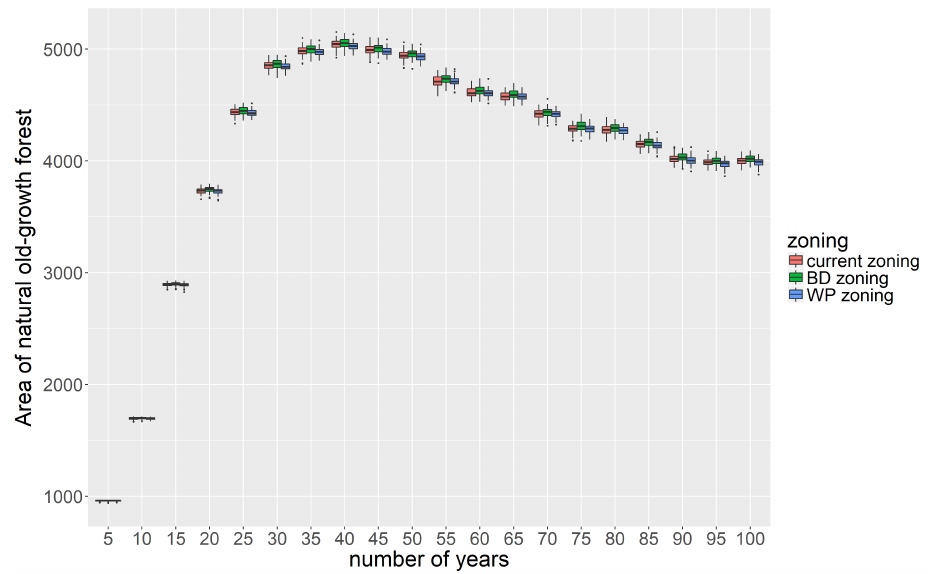
Figure 9. Change of old-growth forest area simulated with the DSS. Boxes show median values, maximum and minimum values, and quartiles of each trial.